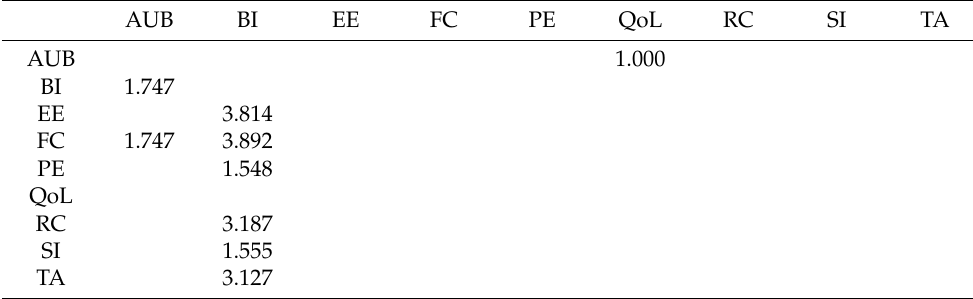
Table A5. Collinearity statistics